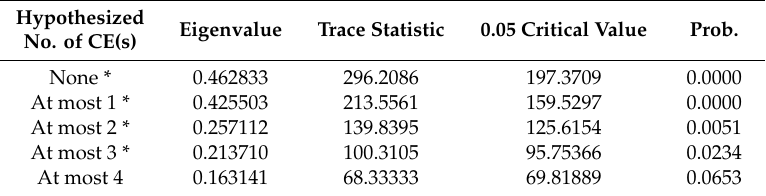
Table 12. Johansen and Juselius cointegration test (trace statistic).